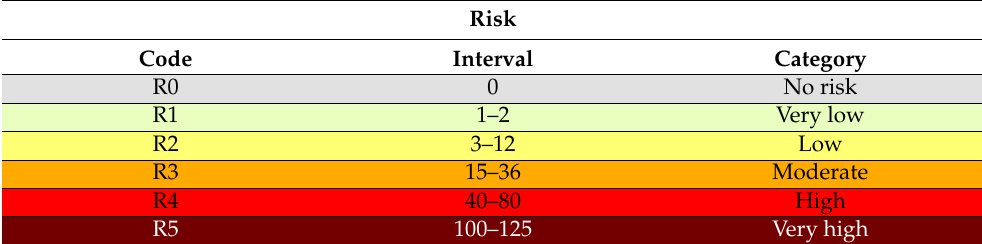
Table 3. Thresholds of the risk intervals used in the risk map.